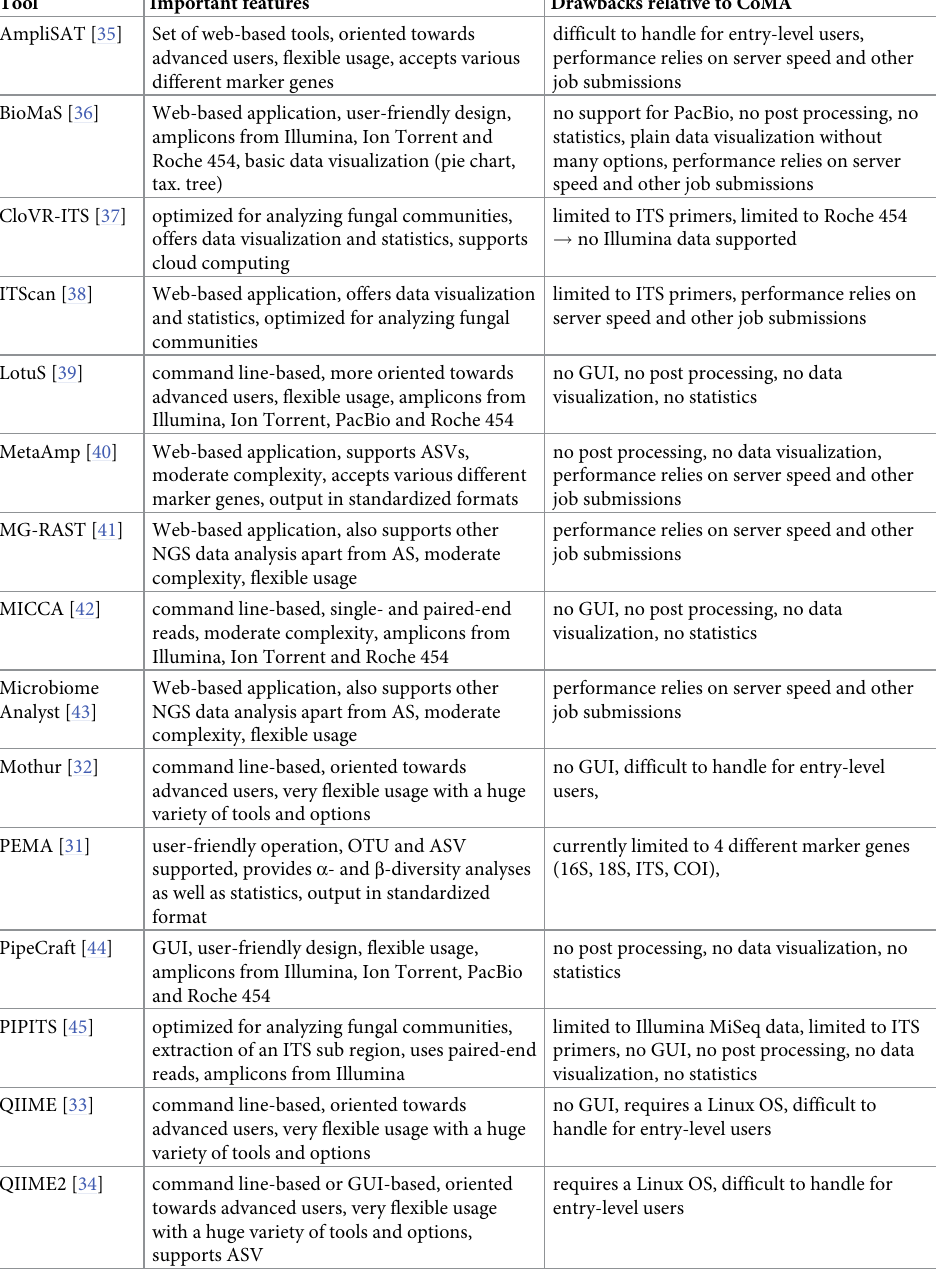
Table 1. Selection of existing software packages available for amplicon sequencing data